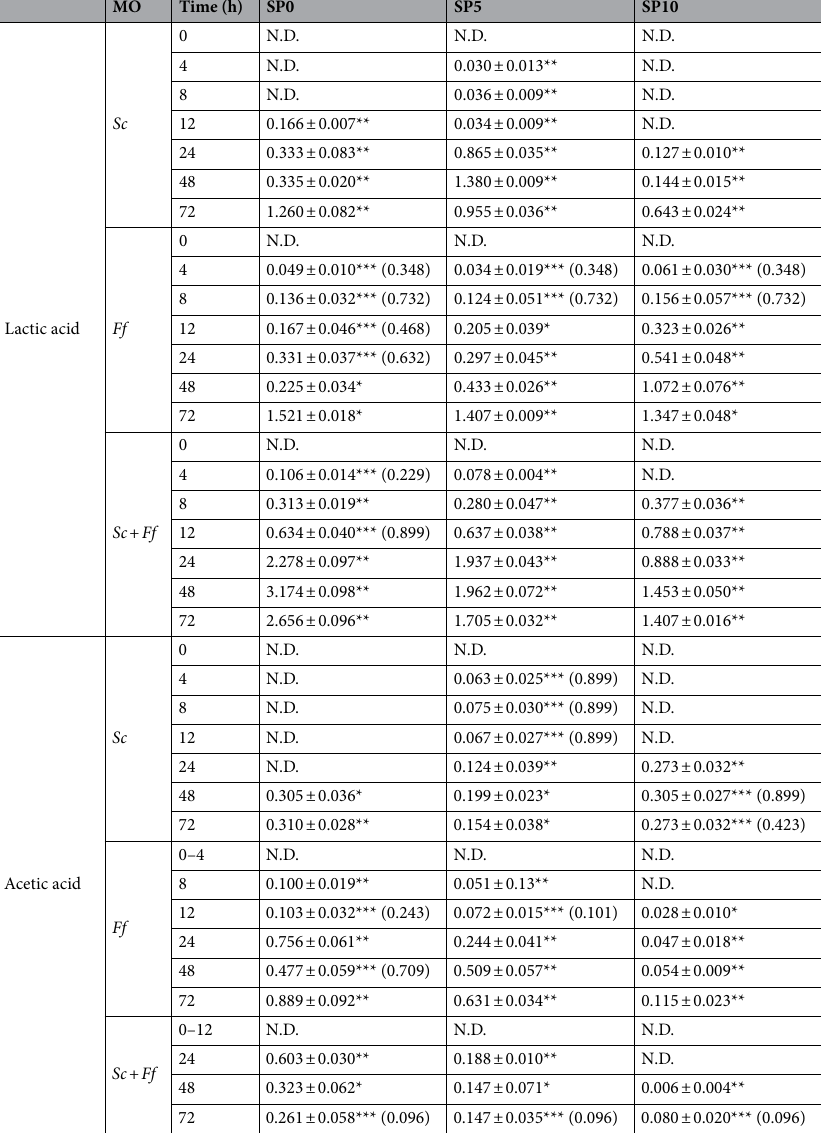
Table 2. Main organic acids concentration through fermentation (reported in g/L). Results (displayed as mean values ± SD, g/L, n = 3). Data normality was investigated applying the Shapiro-Whilk test. For values, p > 0.05, denote normally distributed data (mean ± S.D.). To establish the significant differences between Batch SP0, SP5, and SP10 one-way ANOVA and post-hoc Tukey HSD tests were applied at every moment for every compound. Suppose the F value was p < 0.05, the assessment was carried on, and the significance of differences between means for two batches (SP0 vs SP5; SP5 vs SP10; and SP0 vs SP10) was attained. The Tuckey HSD p-value was introduced in brackets if the p > 0.05 and the symbols for the Tuckey HSD interference are as follows: ** p < 0.01, * p < 0.05, *** p > 0.05, N.D.—not detected. SP0—0% soy powder, SP5—5% soy powder,